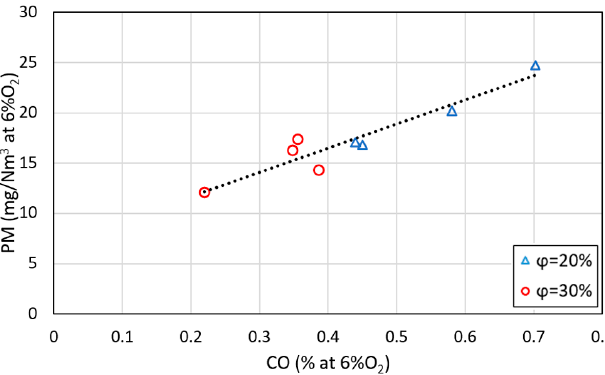
Figure 14. Relation between particulate matter and average CO emissions.